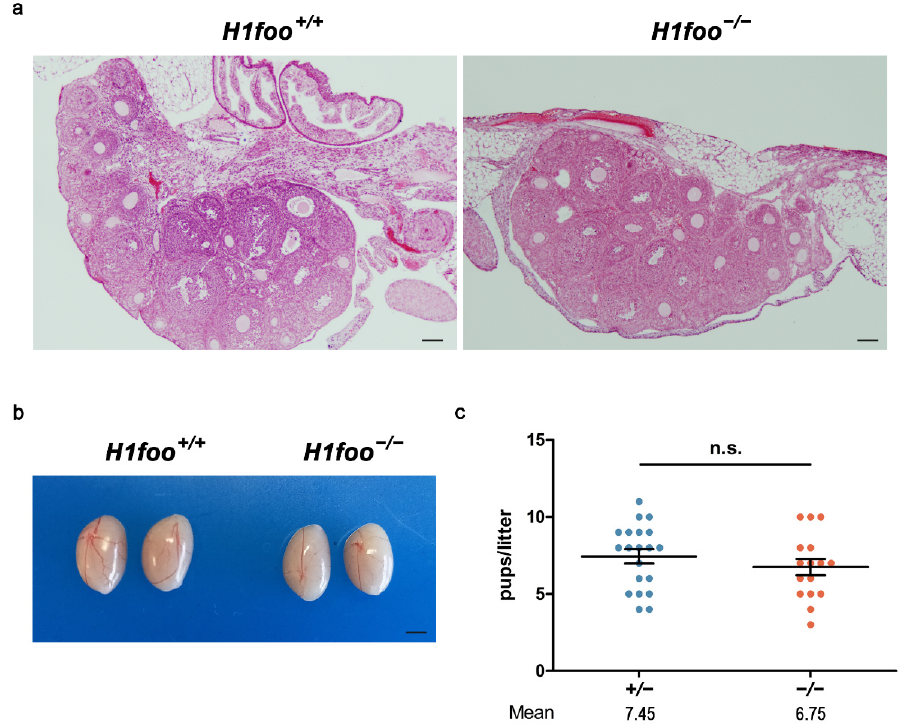
Figure 2. ( a ) Histopathological analysis of hematoxylin-eosin-stained ovaries sections does not show defects in H1FOO-deficient adult mice. Bars in panel, 20 µm. ( b ) Genetic deletion of H1foo entails no differences in testis size when compared to their WT counterparts (mice of 3 months of age). Bar in panel, 30 µm. ( c ) Fertility assessment of heterozygous (+/ − , blue) and homozygous mutant mice ( − / − , red) showing the number of pups per li tt er. Mean value displayed under the plot. Two-tailed Welch’s t -test analysis: n.s., no significant differences.